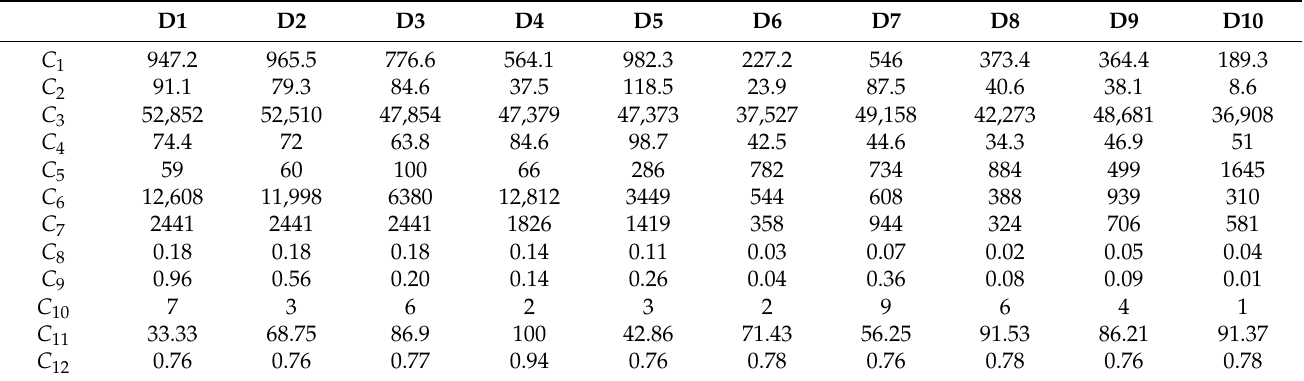
Table 3. Initial data required for the evaluation of indicators.